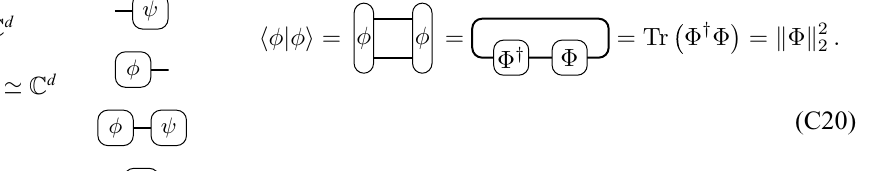
TABLE I. Basic building blocks of wiring calculus. ket